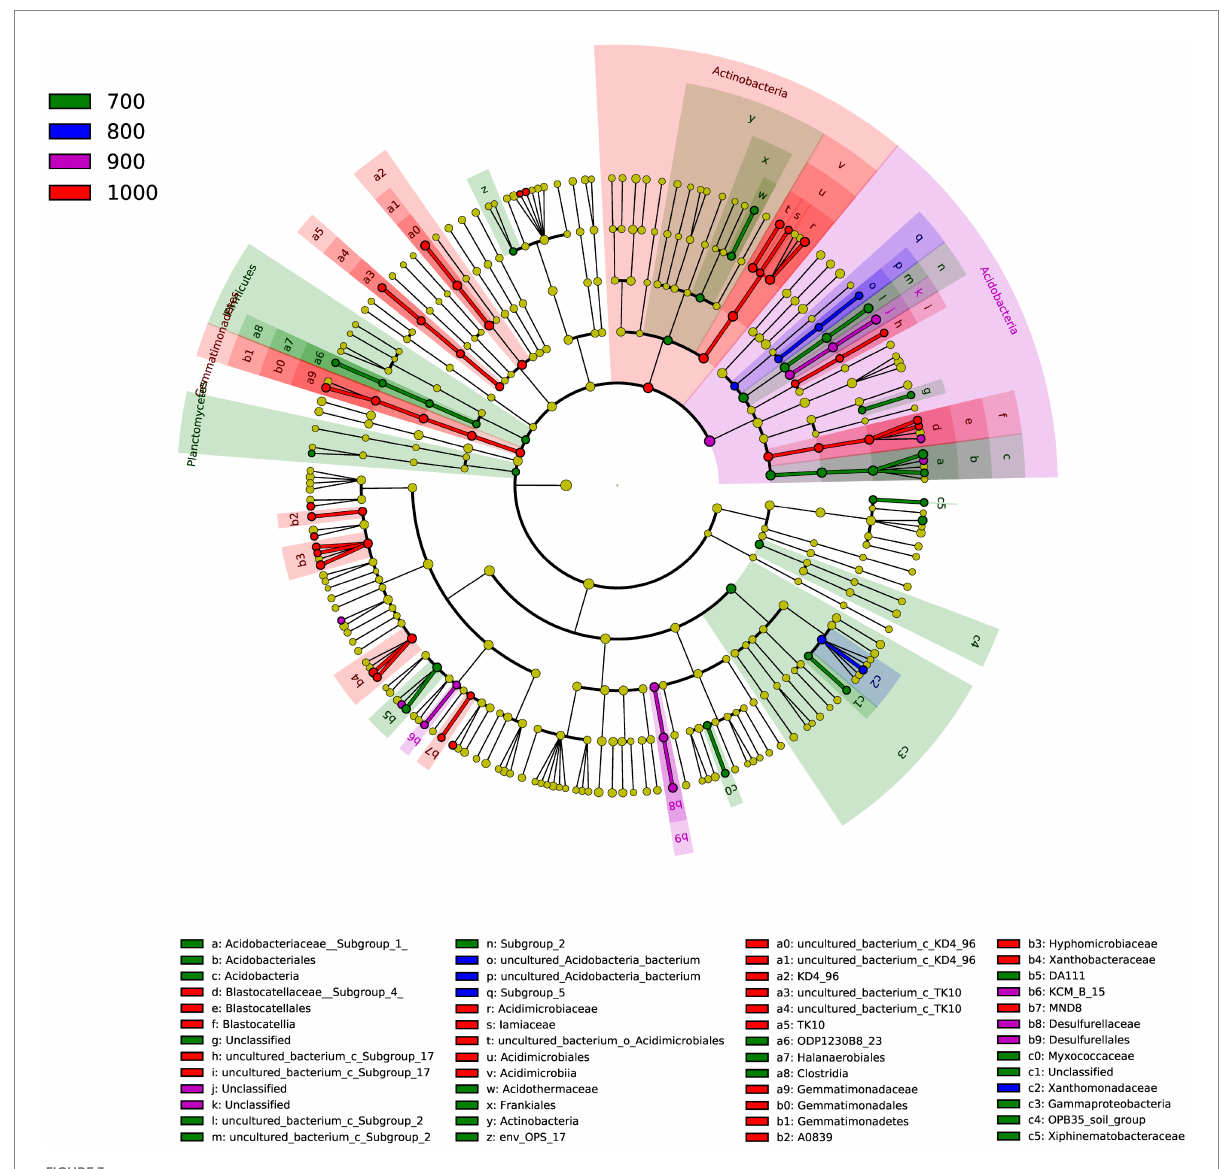
FIGURE 3 Cladogram of the soil bacterial communities with LDA > 4.0 in the four elevations. The circular plot shows bacterial taxa from phyla to genera starting from the